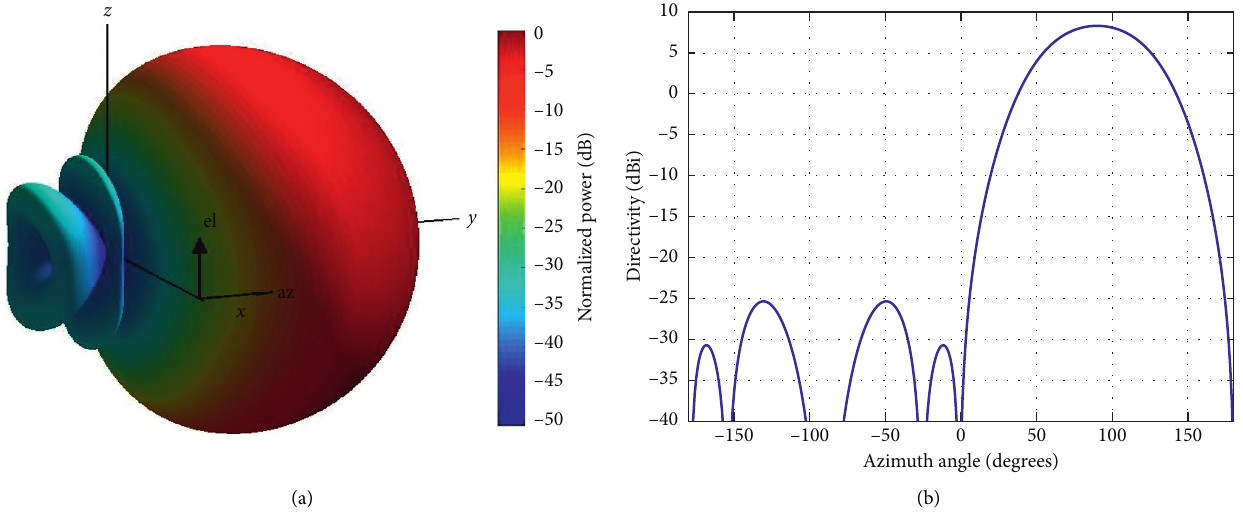
Figure 4: (a) The 3D pattern of the designed array factor. (b) The directivity of the designed array factor for azimuth angles.